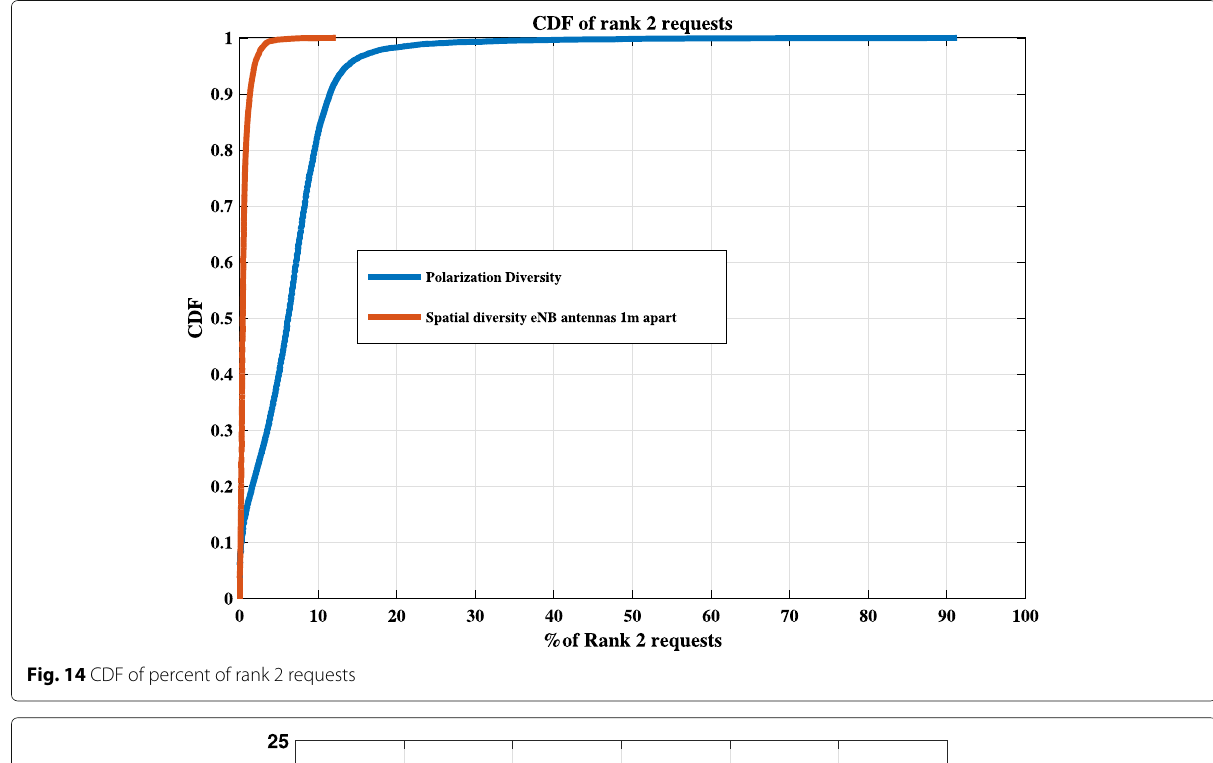
Fig. 14 CDF of percent of rank 2 requests